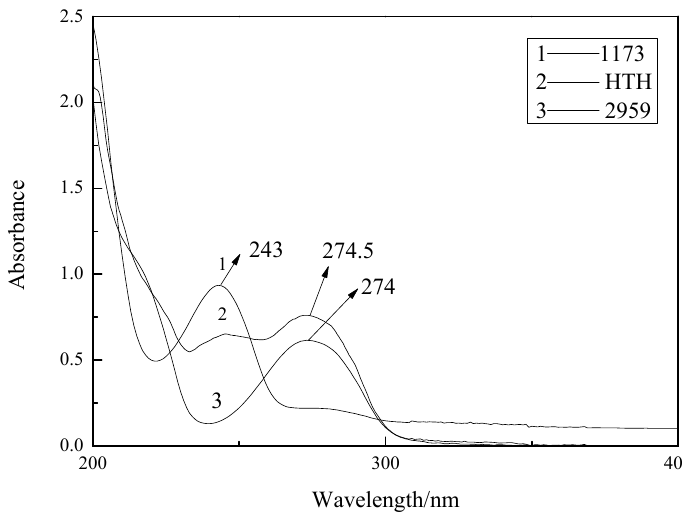
Figure 6. UV-Vis spectra of 1173, 2959, and HTH (solvent: acetonitrile, 25 °C). Table 1. The maximum absorption wavelength and maximum molar extinction coefficient of 1173, 2959, and HTH.